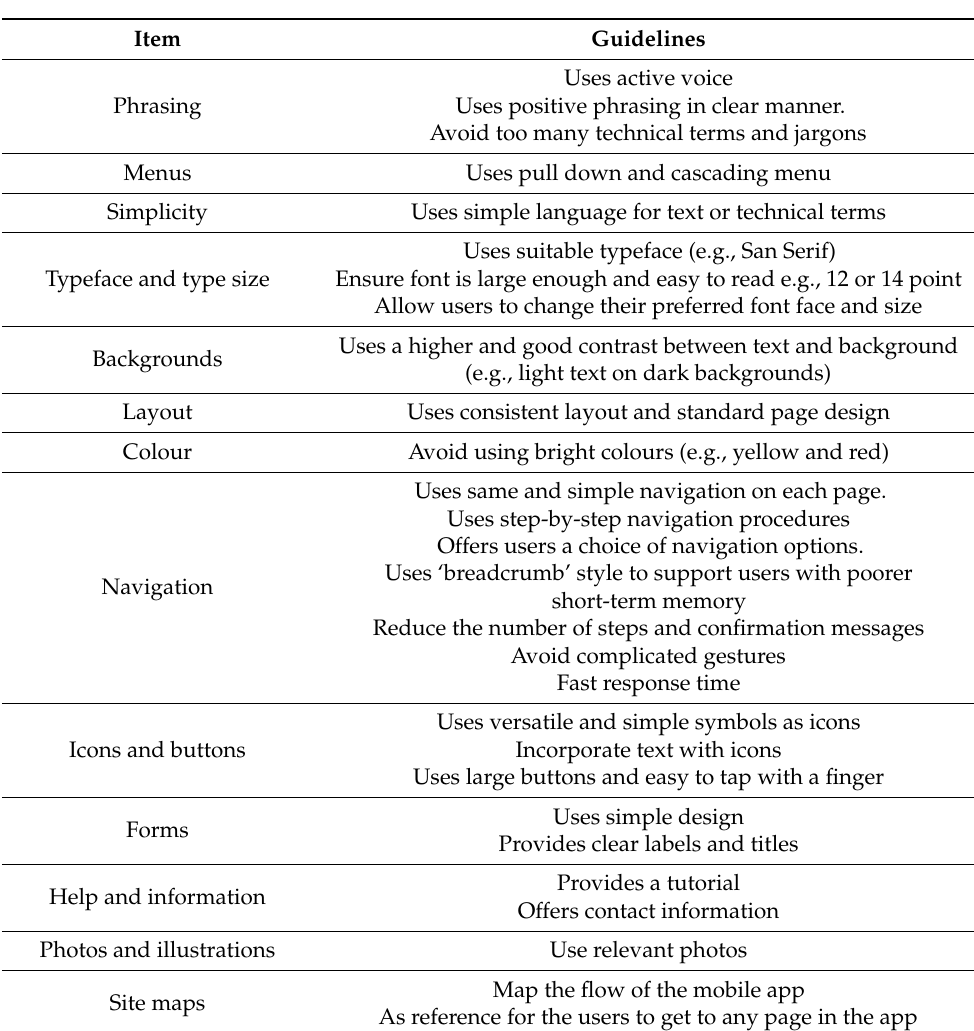
Table 4. The user requirements guidelines.